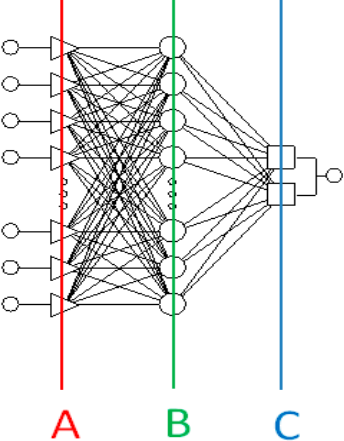
Figure 6. Probabilistic neural network (PNN) with 1 input layer, 1 output layer, and 1 radial hidden layer: A—input layer, number of neurons equal to the number of features; B—hidden layer built of radial neurons also called the pattern layer, the number of neurons is equal to the number of learning instances; C—output layer built of linear classifying neurons (summation layer), the number of neurons is equal to the number of classes.